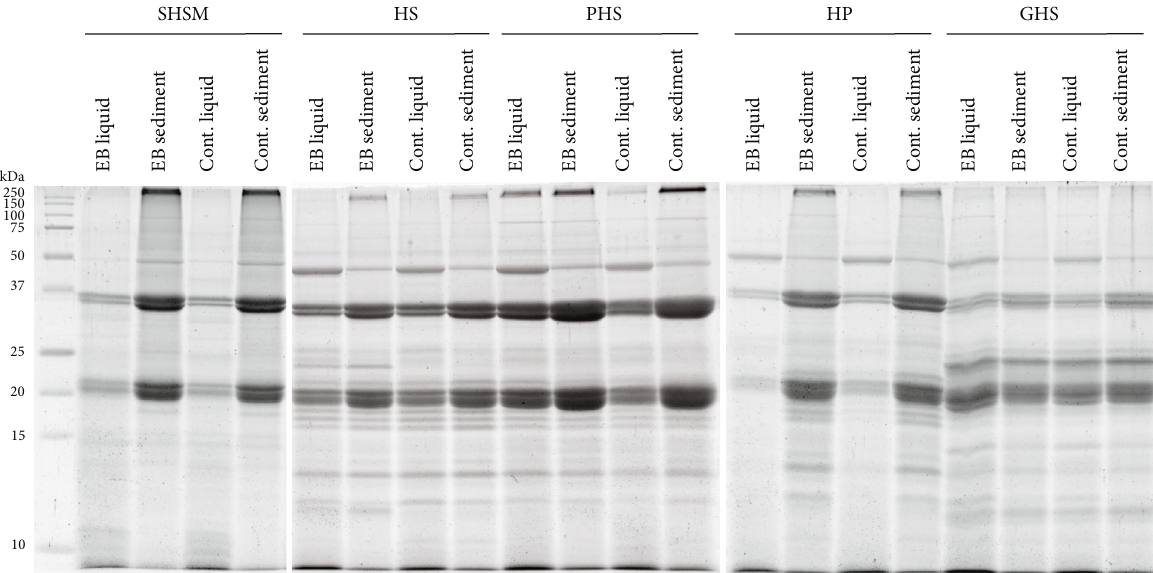
Figure 3: Protein pro fi les of hemp raw materials before and after enzyme treatment. SDS-PAGE was performed to compare protein pro fi les between raw materials, hempseed meal after oil recovery (SHSM), hempseed (HS), peeled hempseeds (PHS), hempseed protein (HP), and germinated hempseeds (GHS) before and after an enzyme blend for alcohol CGE (EB) treatment. Protein pro fi les were analysed from both the liquid and sediment fraction of the